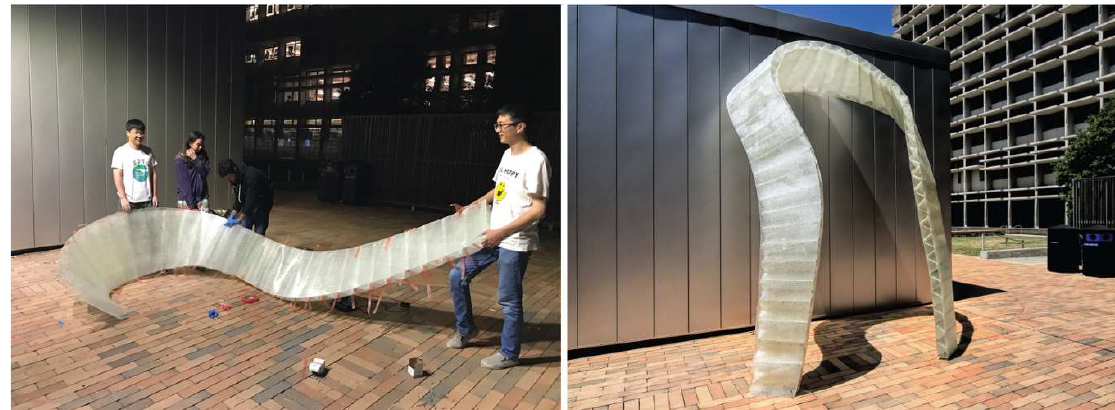
Figure 19. Students assemble the 8-m-long, curved sandwich strip of the pavilion in full scale.